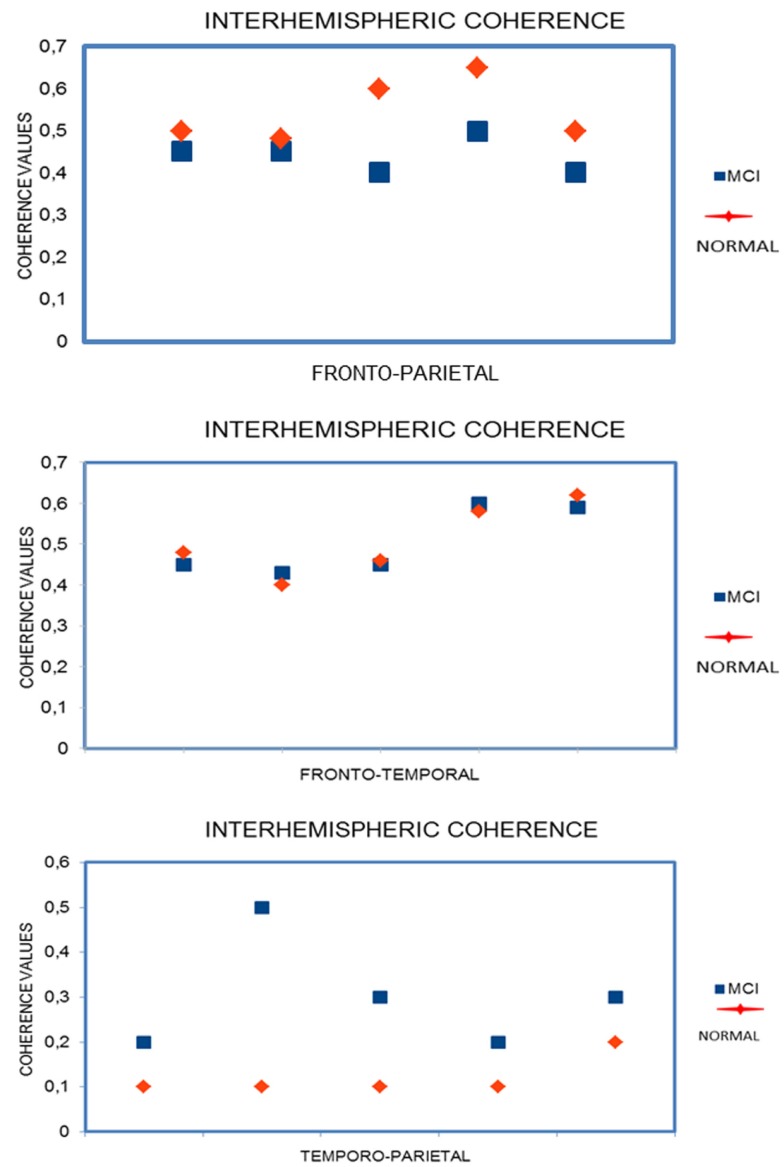
EEG Coherence statistical results.